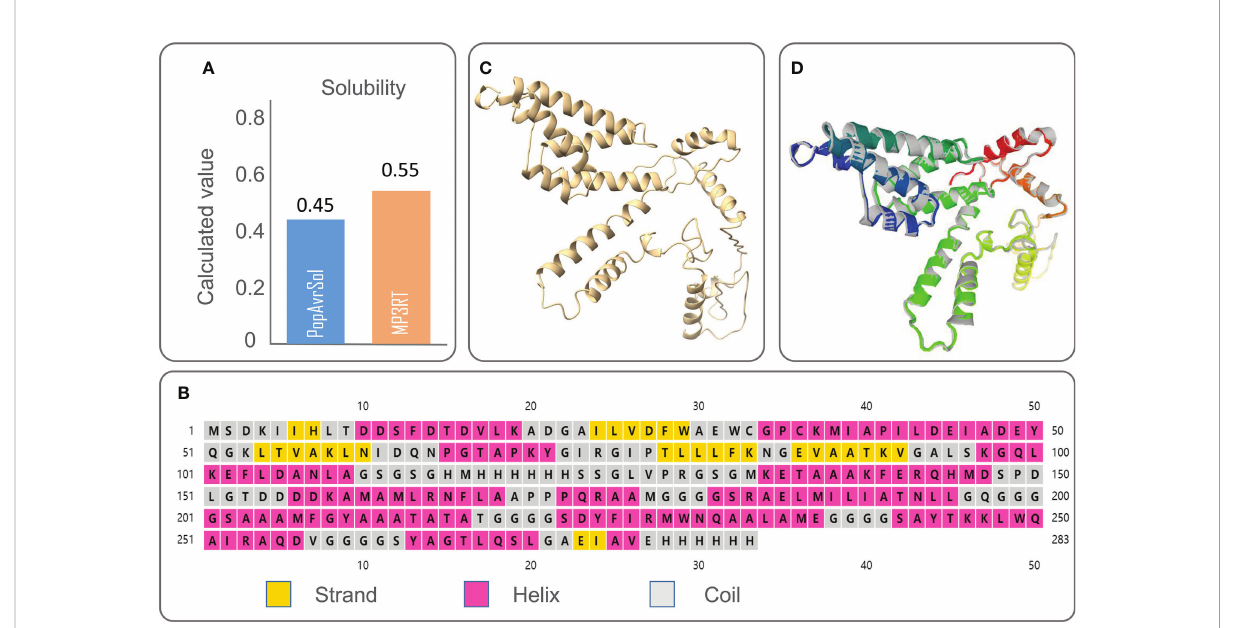
FIGURE 1 The solubility, secondary structure, tertiary structure, and optimized tertiary structure of the MP3RT vaccine. (A) Solubility of the MP3RT vaccine was predicted by the Protein – Sol server. (B) Secondary structure of the MP3RT vaccine was predicted by the PSIPRED server. (C) The 3Dpro serve was used to predict the tertiary structure of the MP3RT vaccine before optimization. (D) The optimized tertiary structure of the MP3RT vaccine was predicted by the Galaxy WEB server. The colored parts in the picture are improvements to all sidechain structures that initialize the model, improving the structure accuracy and physical correctness of the global and partial parts through repeated